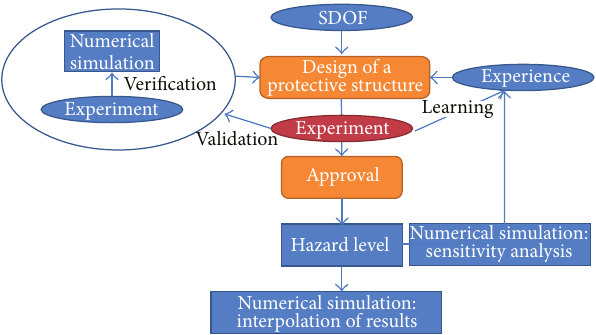
Figure 3: Interaction between numerical simulations and experi-